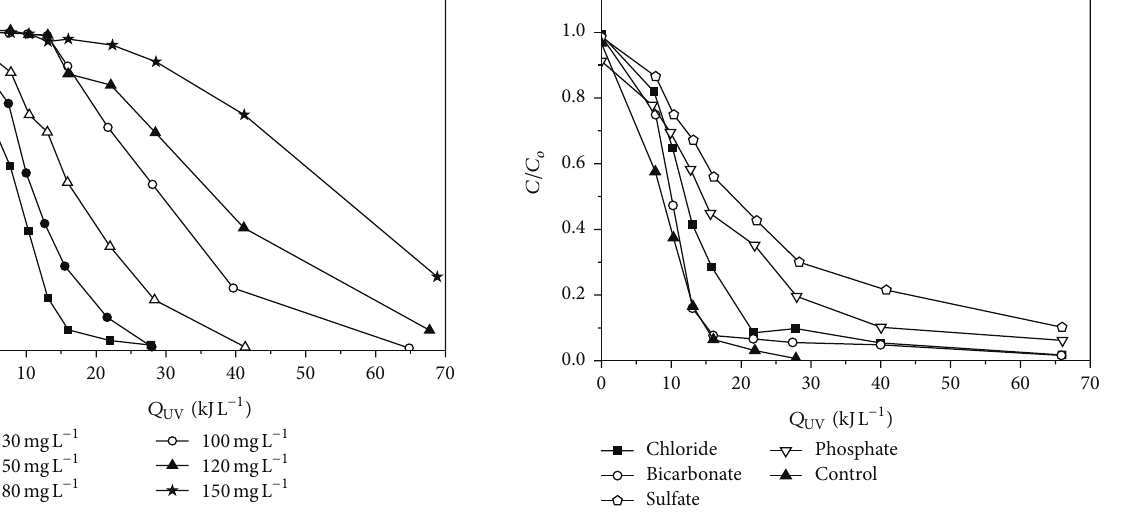
Figure 3: Effect of initial concentration of IC on the photocatalytic degradation with 0.1 gL −1 of TiO 2 suspensions.